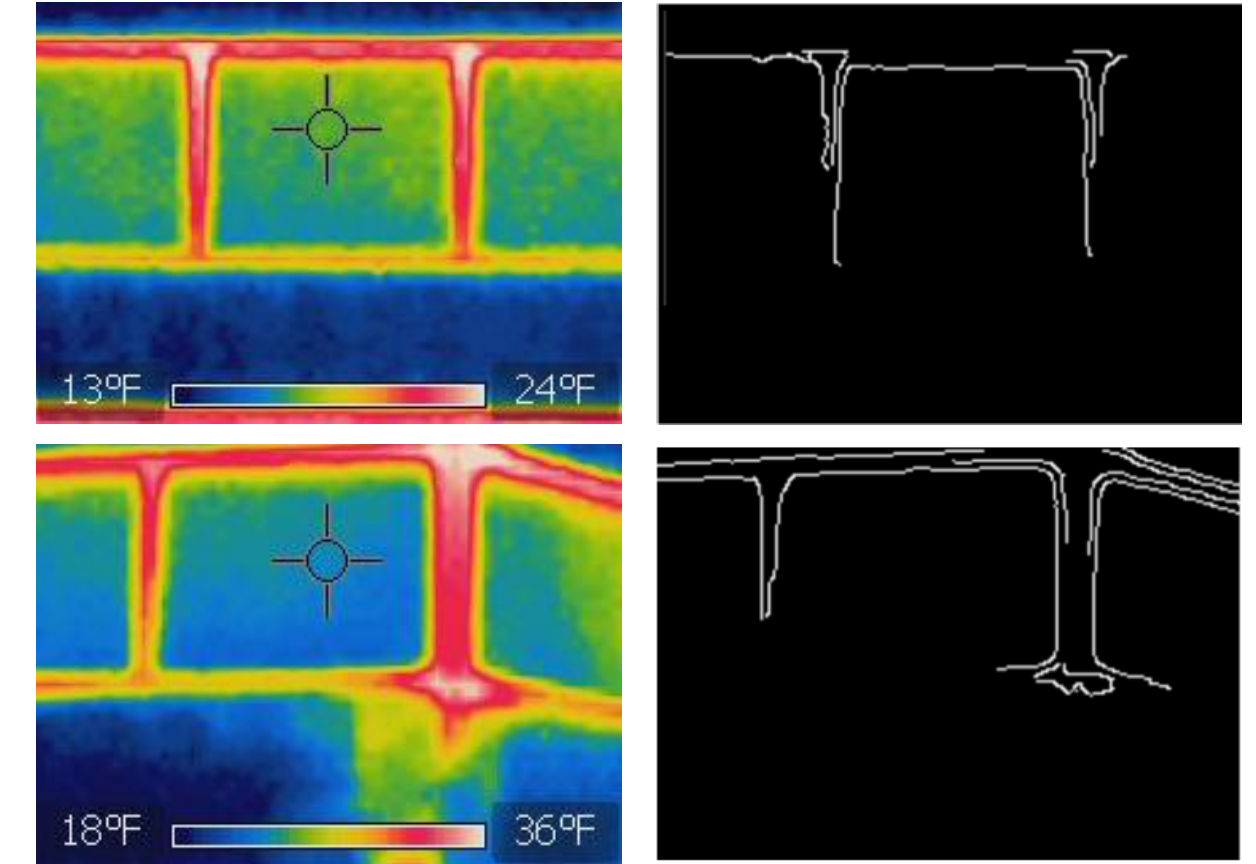
Figure 13. Results from the thermal images using the Canny contour detector.